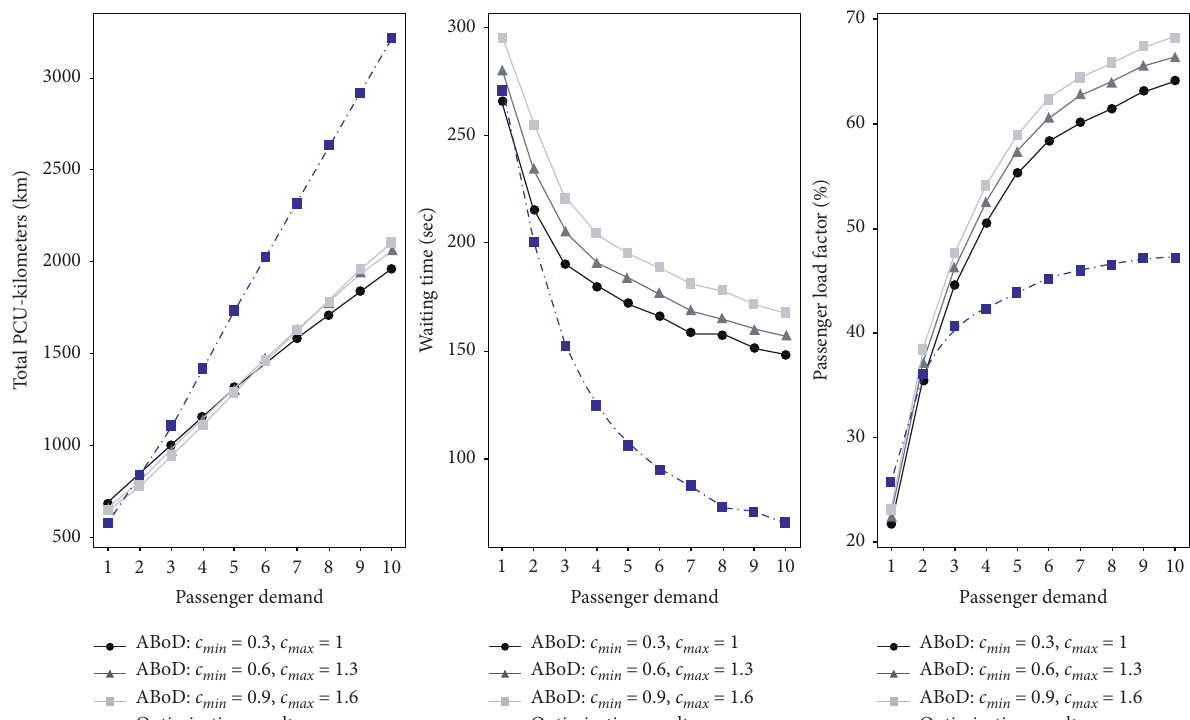
Figure 10: Simulation results of ABoD and optimization model.